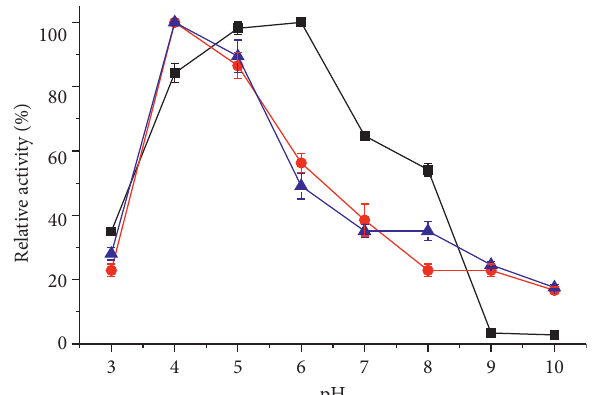
Figure 3: Effect of pH on the endoglucanase ( ), exoglucanase ( ), and β -glucosidase ( ) activity. The error bars represent the mean ± SD ( n � 3).